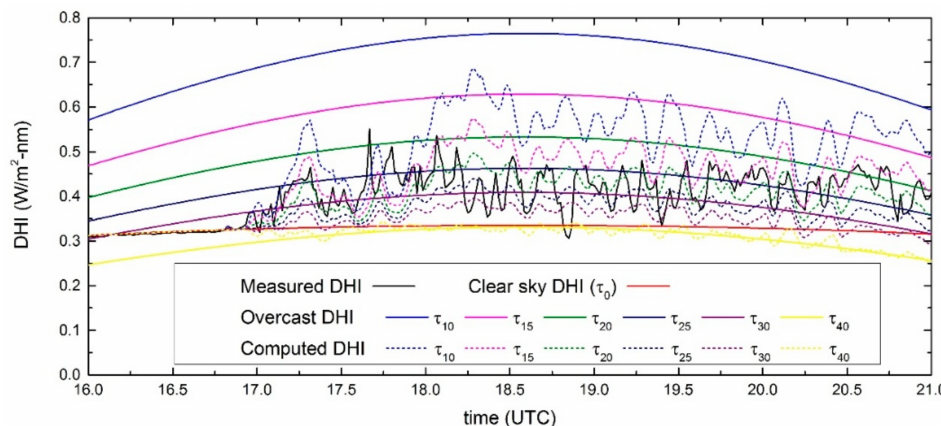
Figure 4. The simulation of diffuse solar irradiance on 7 July